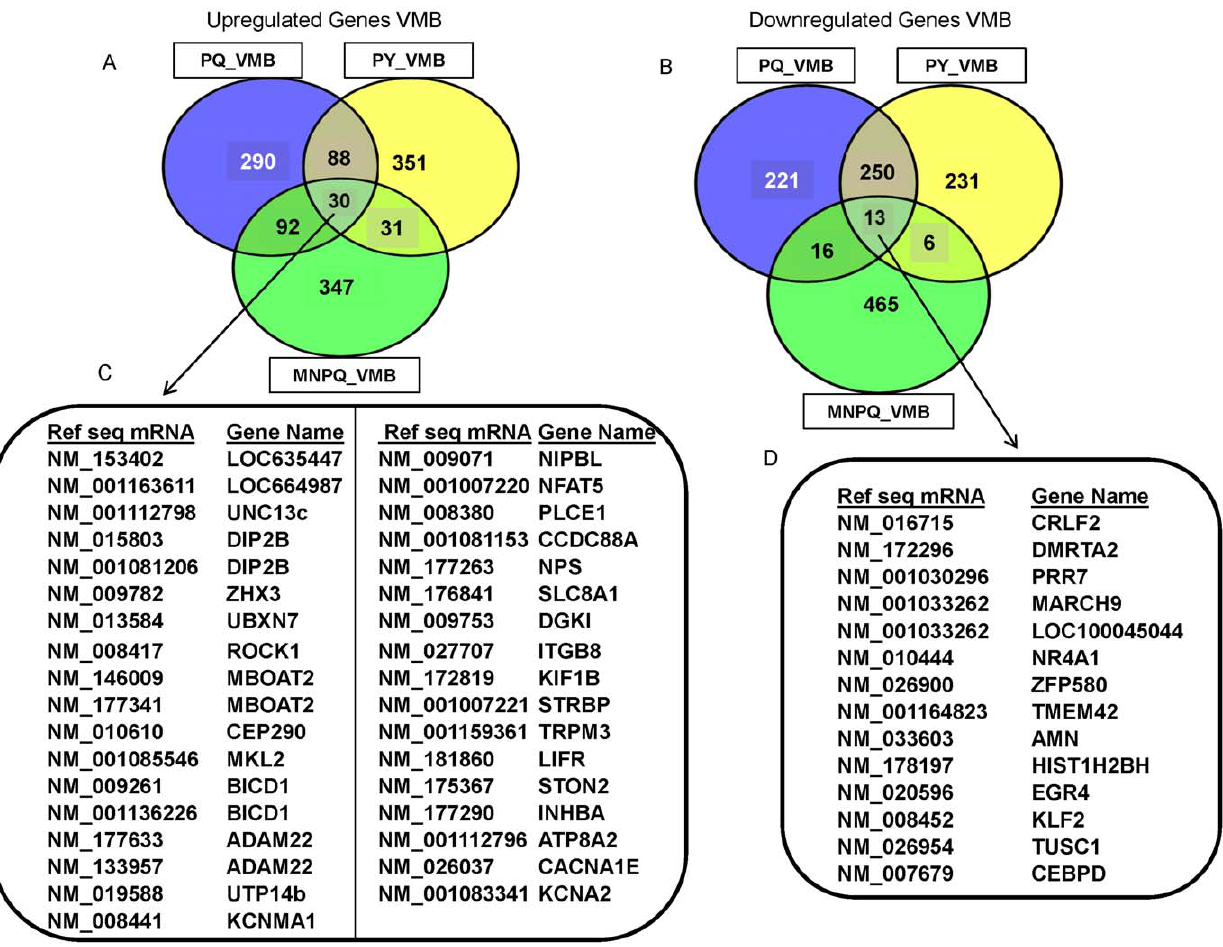
Figure 3. Common genes in the VMB between PQ, PY and MNPQ mouse models of PD. A) Venn diagram of 500 up-regulated VMB transcripts from PQ, PY and MNPQ models of PD. B) Venn diagram of 500 down-regulated VMB transcripts from PQ, PY and MNPQ models of PD. C) Common up-regulated genes in the VMB of PQ, PY and MNPQ models of PD. D) Common down-regulated genes in the VMB of PQ, PY and MNPQ models of